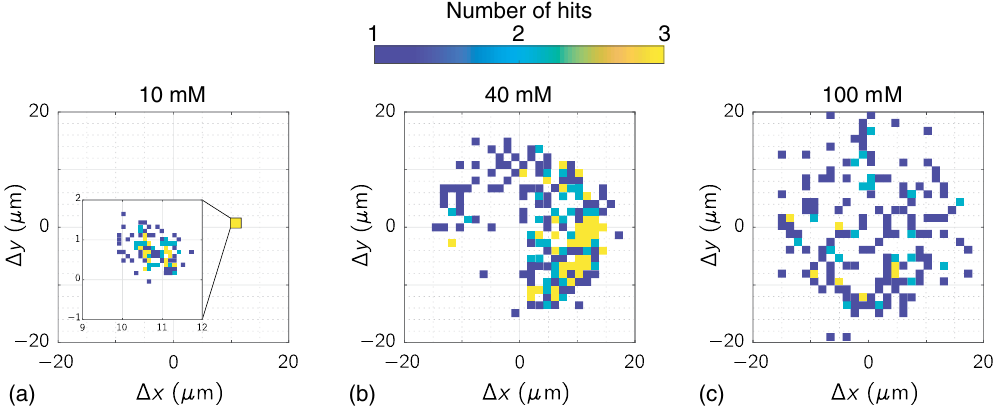
FIG. 8. Displacements of the droplet between consecutive time steps (i.e., Δ t ¼ 25 ms), for three surfactant concentrations. Colors represent the density at which this location in the displacement field is hit along the